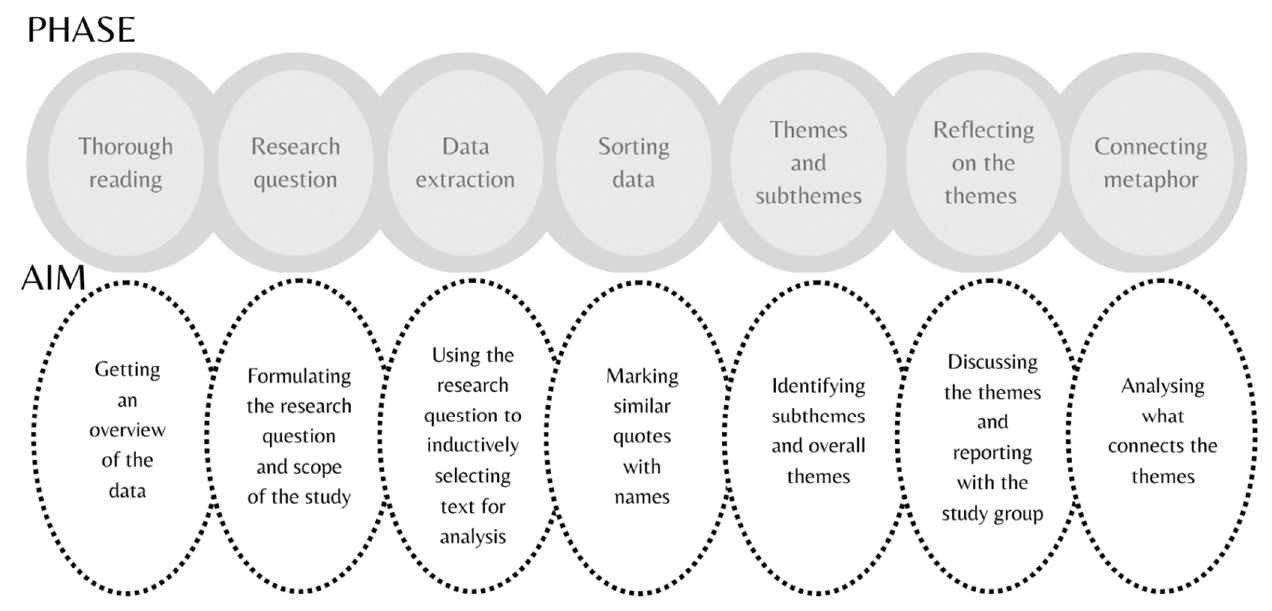
Figure 1. The phases of data analysis and the aim of each step of the analysis.